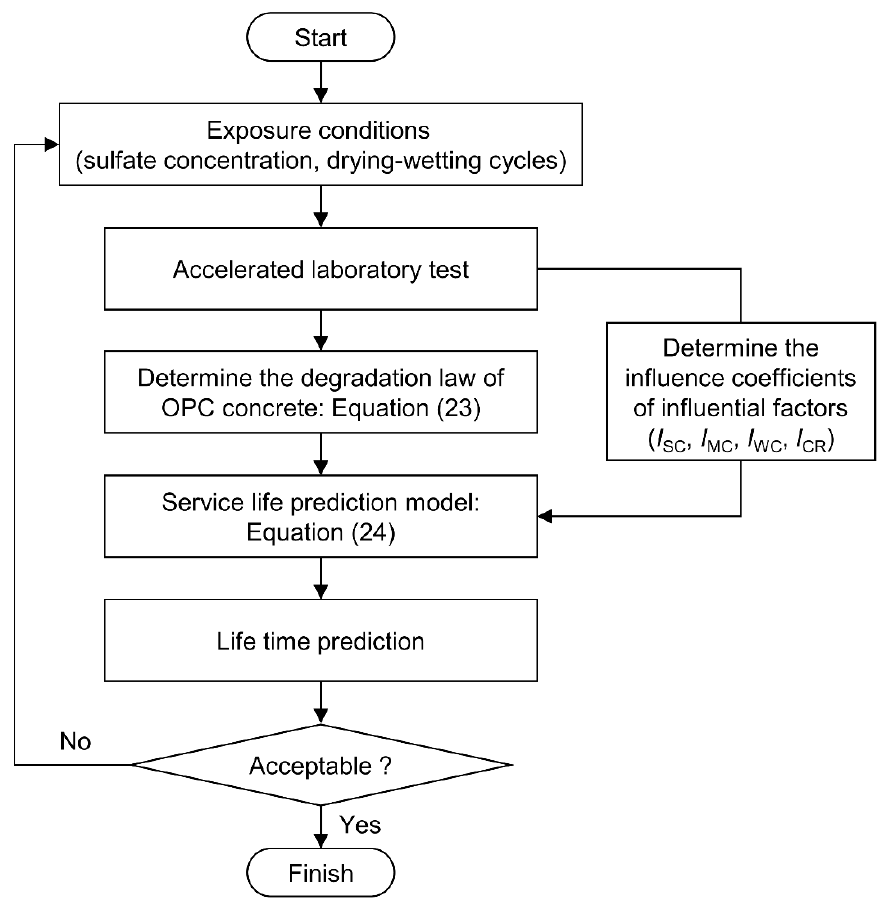
Figure 8. Flowchart for service life prediction of concrete subjected to DW cycles with SA.